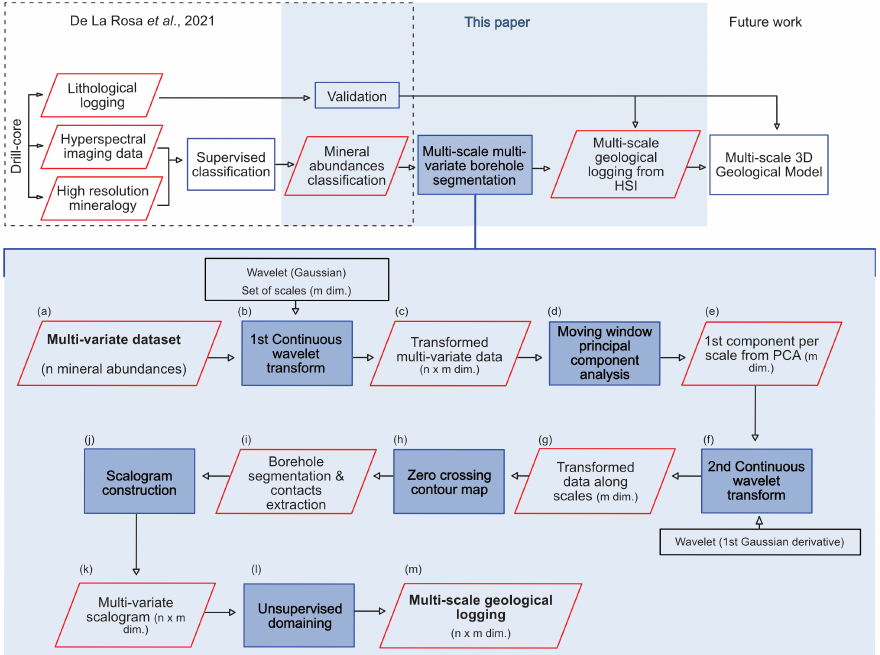
Figure 1. General workflow for multi-scale, multivariate borehole segmentation from hyperspectral drill-core data [9]. Panels ( a , c , e , g , i , k , m ) with outer red border represents the input and output data for each step of the method workflow. Panels ( b , d , f , h , j , l ) represents the main steps for the multi-scale multivariate borehole segmentation